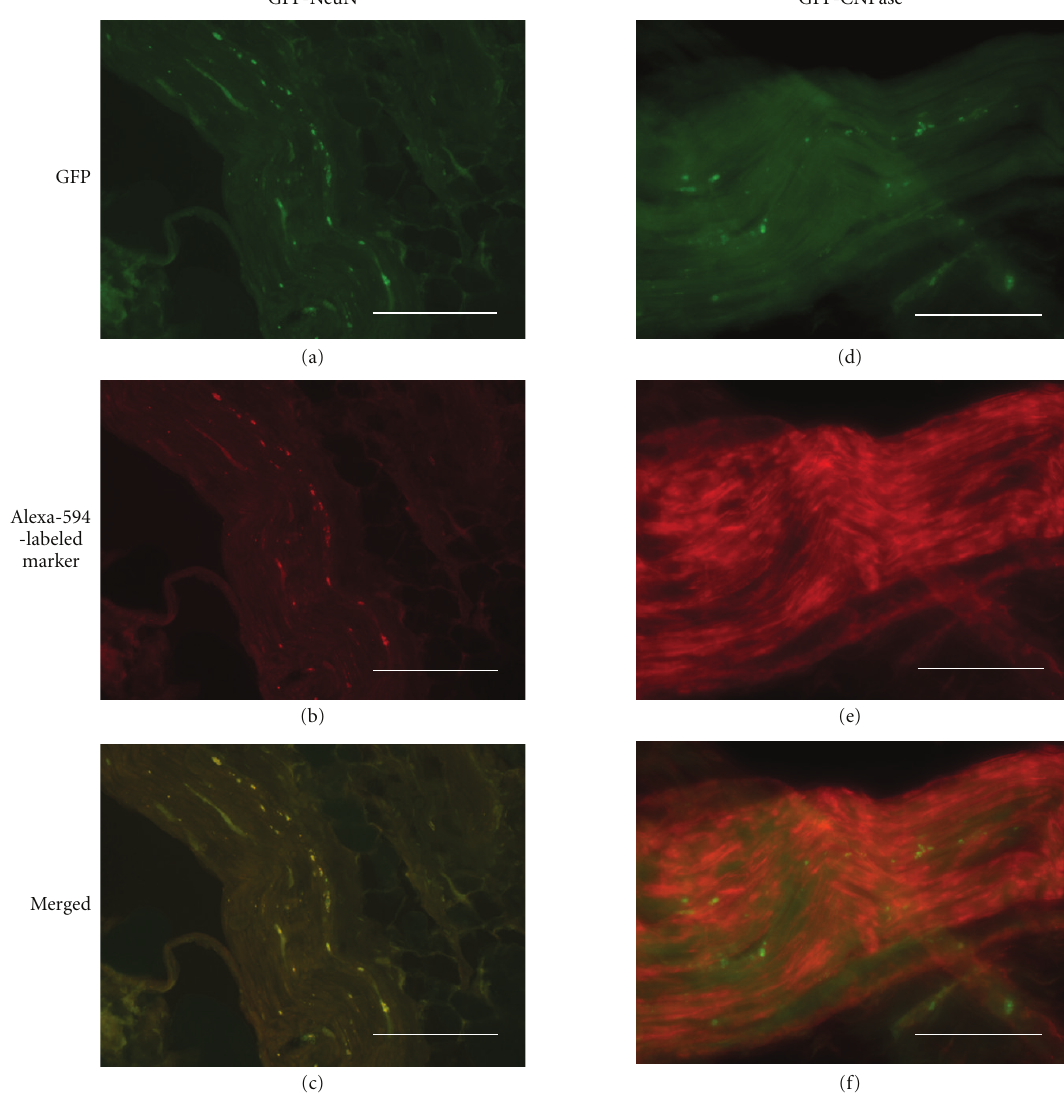
Figure 7: GFP detection and phenotypic marker immunohistofluorescence (NeuN on left column, Schwann cells’ CNPase on right column) in sagittal sections of venous bridges which had been transplanted with LV-GFP-labeled neurospheres and were sampled at 240 days after lesion. (a, d) green endogenous fluorescence for detection of lineage-infected neurosphere progeny; (b, e) Alexa-594-revealed phenotypic marker immunoreactivities; (c, f) merged fluorescences. Note yellow-labeled colocalization of GFP-expressing neurosphere progeny with NeuN immunoreactivity (c) but not with CNPase (f). Scale bars: 0.5